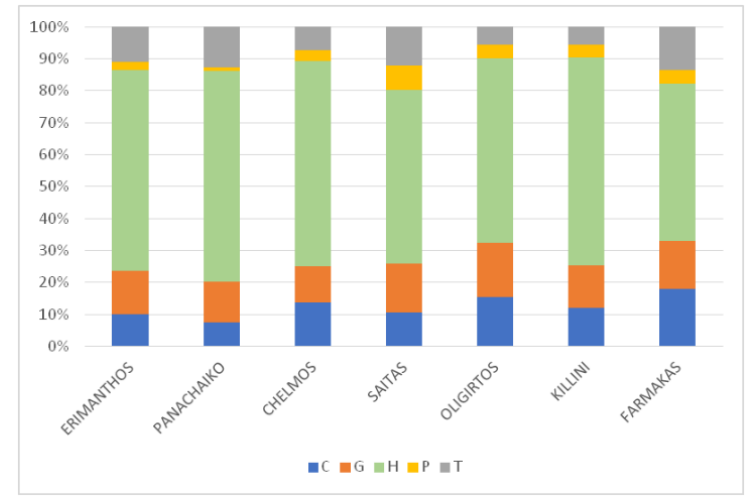
Figure 6. Life form spectra of the Greek endemic flora of Mts. Erimanthos, Panachaiko, Chelmos, Saitas, Oligirtos, Killini, and Farmakas. C: chamaephytes, G: geophytes, H: hemicryptophytes, P: phanerophytes, T: therophytes. (Kruskal – Wallis one-way ANOVA: H = 3.176, df = 6, p = 0.787).